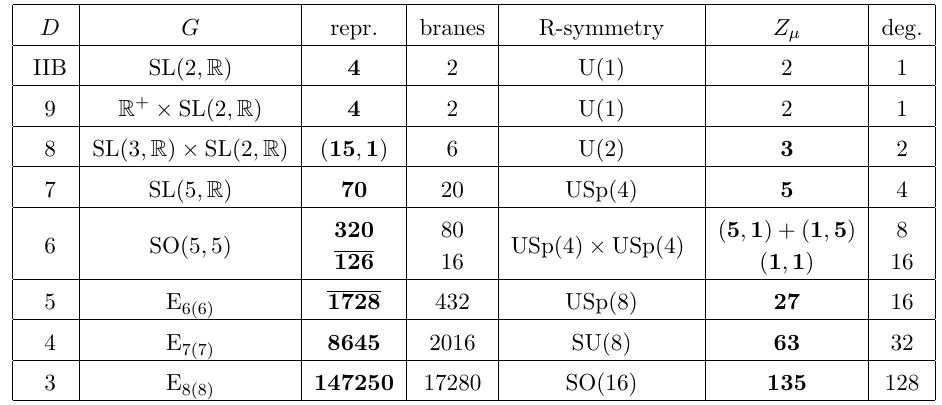
Table 1 . The 1/2-BPS space-(cid:12)lling branes of the maximal theories in any dimension and their degeneracy [12]. The number of branes is given in the fourth column, while the third column contains the representation of the corresponding D -form potential. The sixth column contains the representation of the central charge and in the last column we list the degeneracy, which is simply the ratio of the number of branes to the dimension of the representation of the central charge. In six dimensions the (cid:12)rst line corresponds to branes supporting a vector multiplet, and the second line to branes supporting a tensor